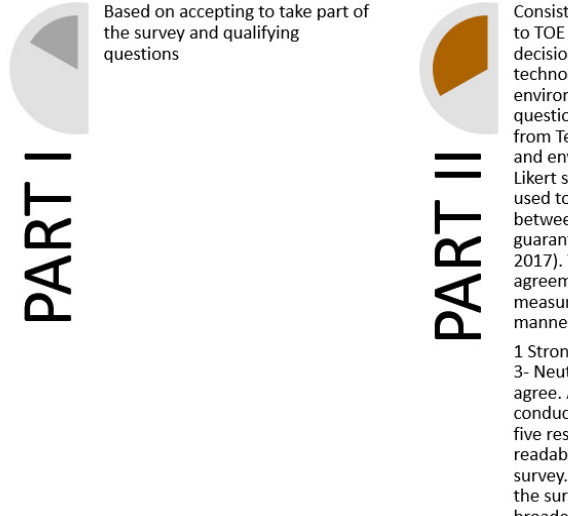
Figure 9. Measurement item.